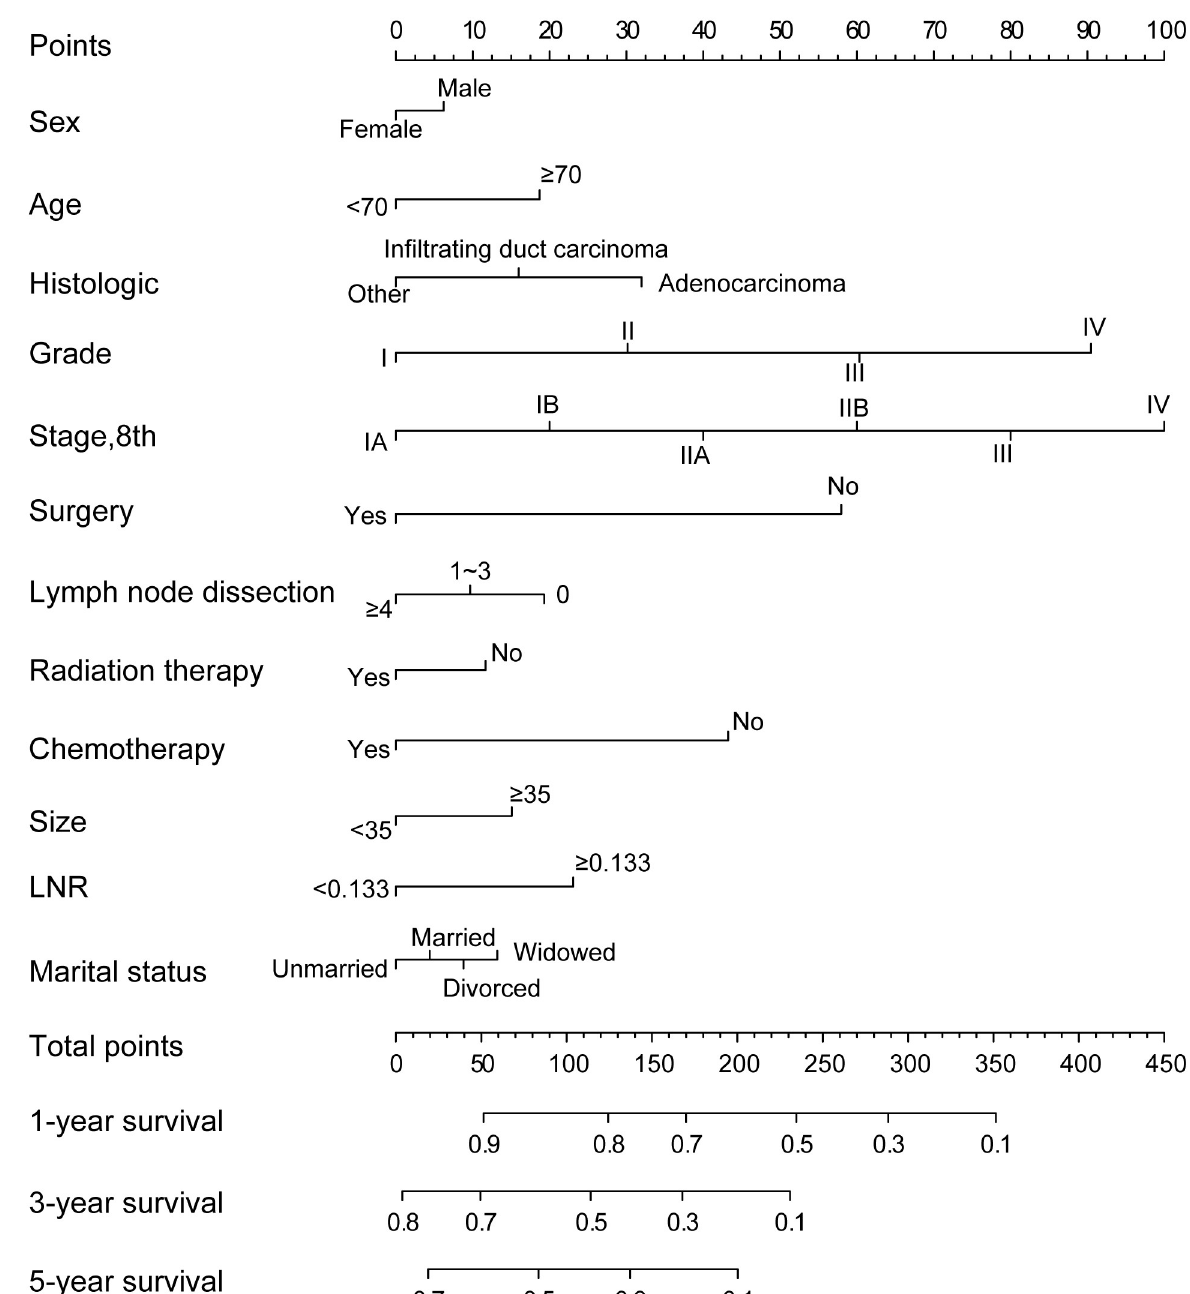
Fig 1. Nomogram for predicting the 1,3- and 5-year overall survival of patients with pancreatic cancer. were included following rigorous screening, and 12 risk factors that significantly affected prog- nosis were determined by the Cox regression method. A nomogram was constructed based on these 12 risk factors. The C-index and the graphical calibration method were used for internal validation, which suggested that the nomogram exhibited a good predictive ability.